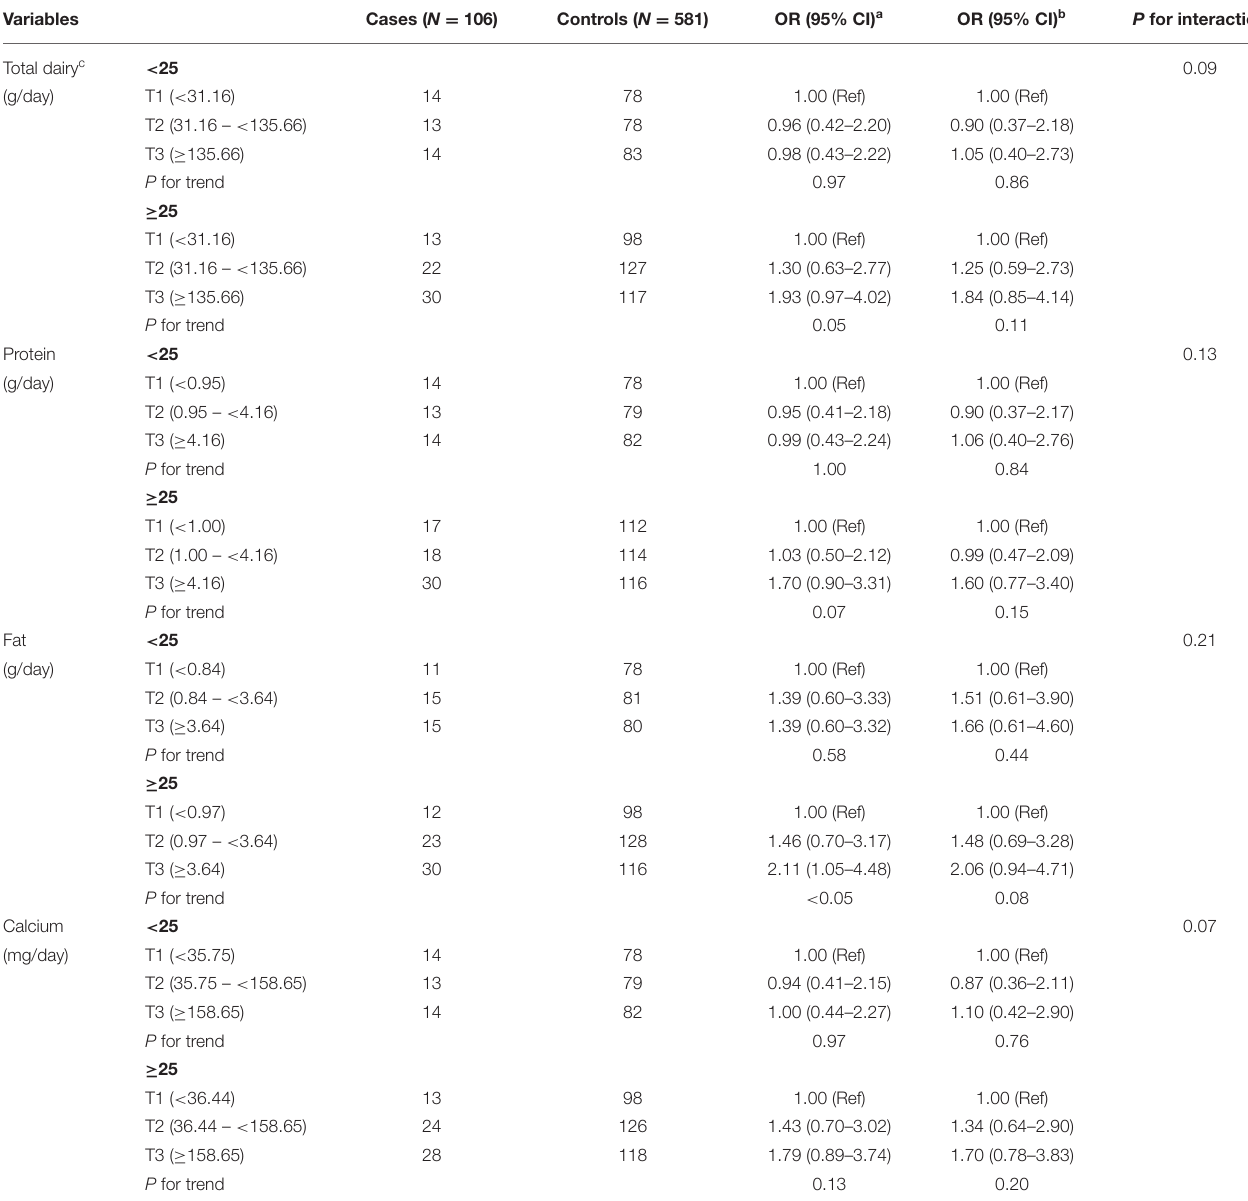
TABLE 3 | Adjusted ORs and 95% CIs for oligo-astheno-teratozoospermia by intake of dairy products and their related nutrients, stratified by body mass index. Variables Cases ( N = 106) Controls ( N = 581) OR (95% CI)